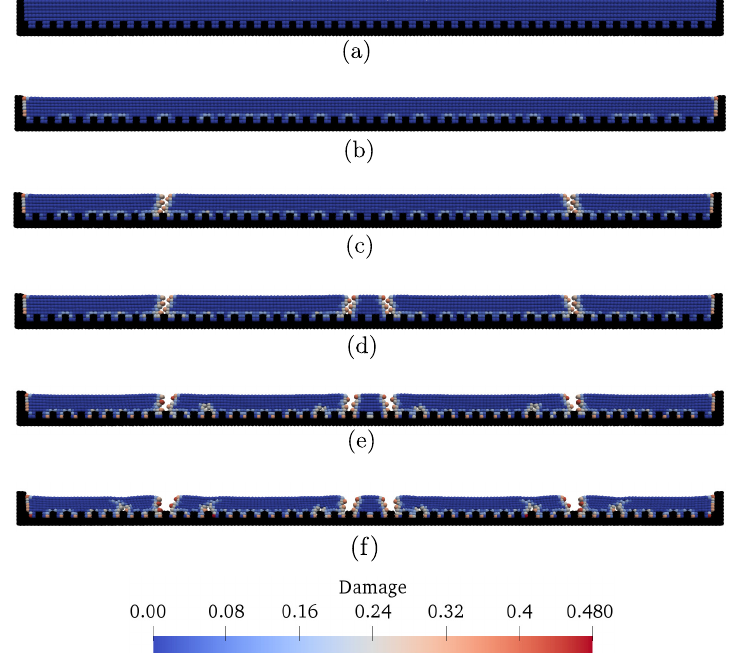
Figure 3. Snapshots of contours of the damage variable superimposed on the deformed configuration at 6 load steps: ( a ) Step 1; ( b ) Step 50; ( c ) Step 90; ( d ) Step 100; ( e ) Step 180; ( f ) Step 250. Note: The deformation is amplified by a factor of 15 to highlight the formation of cracks.